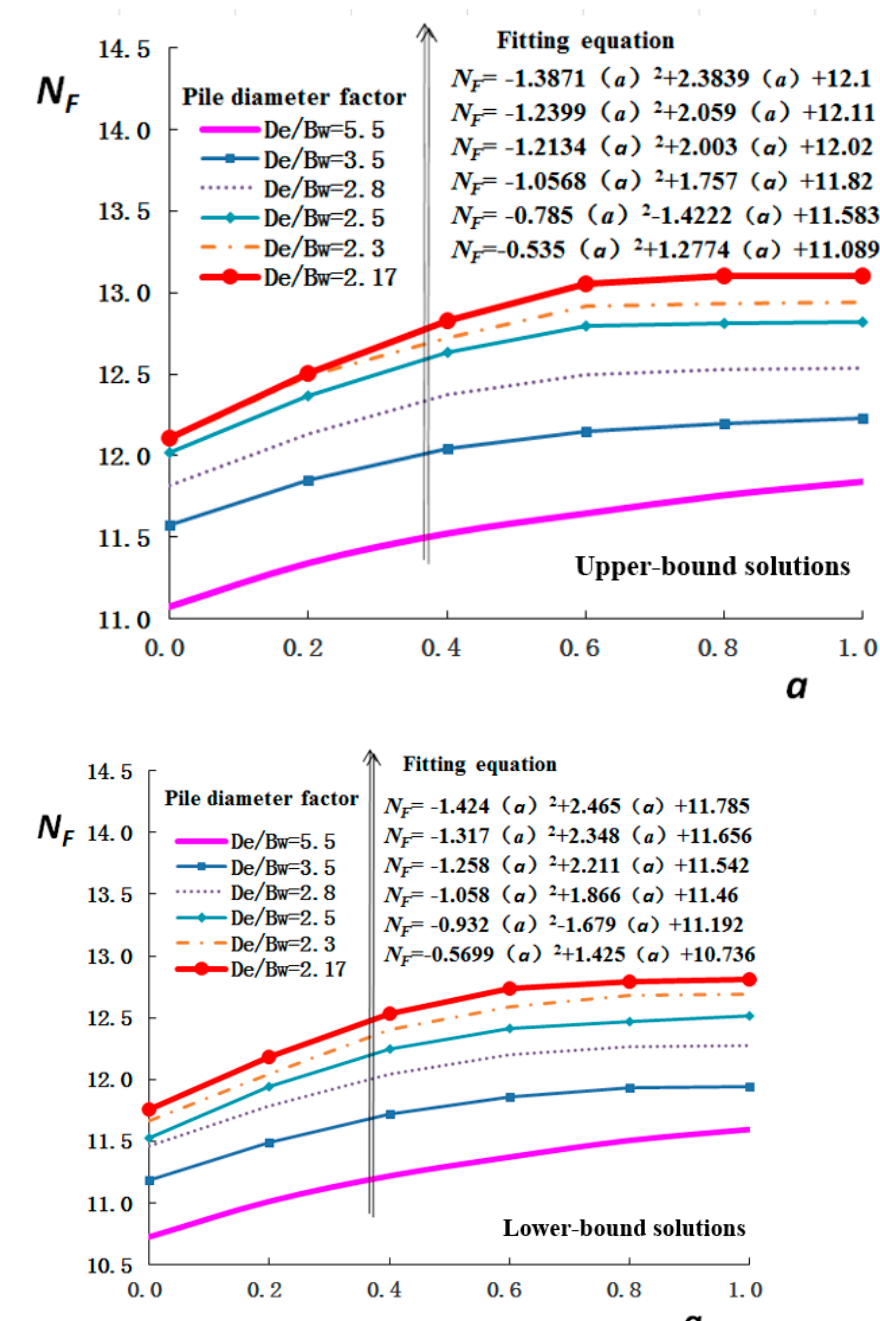
Figure 7. Relationship between the normalized ultimate lateral capacity ( N F ) of the three-wing pile and the pile–soil interaction coefficient ( α ) when lateral-load angle β = 0. ( Top ) Upper-bound and ( Bottom ) lower-bound solutions from limit analysis with different wing-to-diameter ratios. ( D e : effective diameter; B w : wing width.).